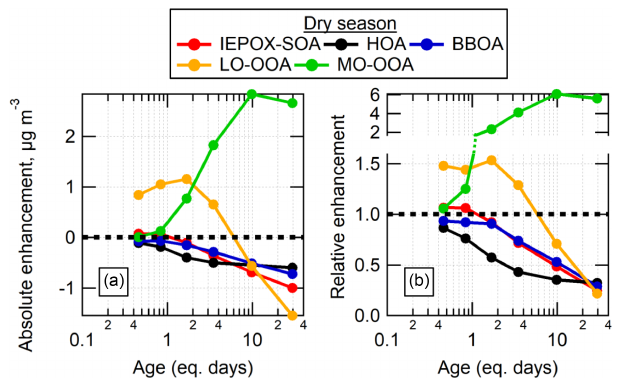
Figure 10. Absolute (a) and relative (b) changes in PMF factors as a function of eq. days of OH aging in the OH-OFR for the dry season. Note that the y axis in (b) is split in order to more clearly show the region below a value of